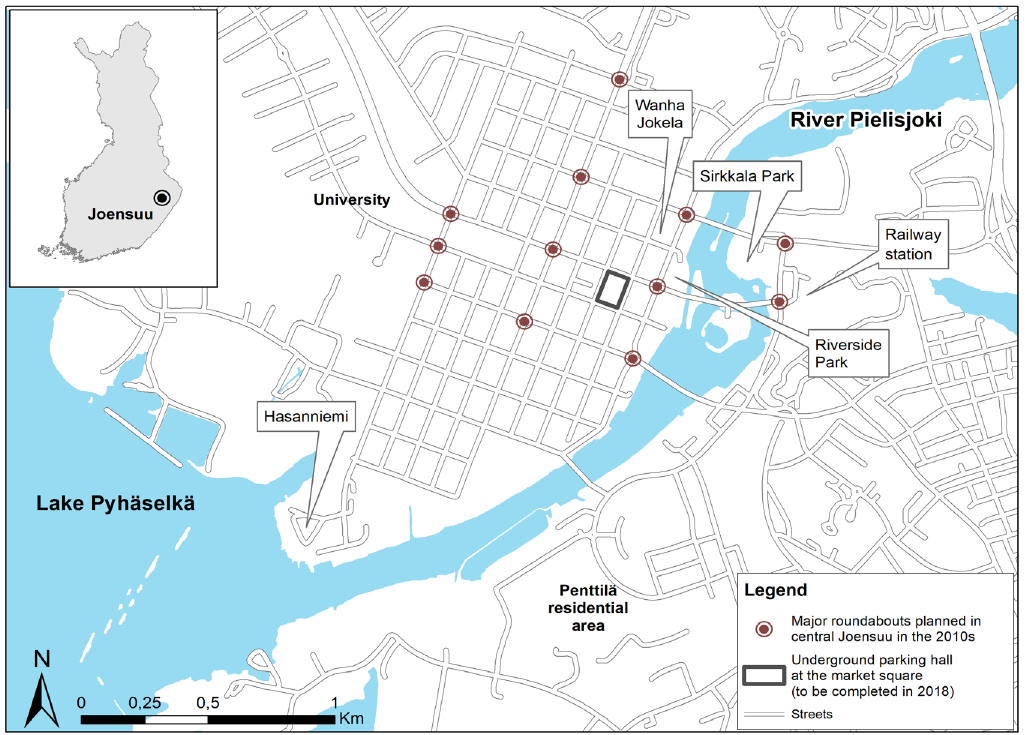
Fig. 2. Major planning disputes in central Joensuu in the 2010s. Copyright Noora Rämö. Contains data from the National Land Survey of Finland Topographic Database